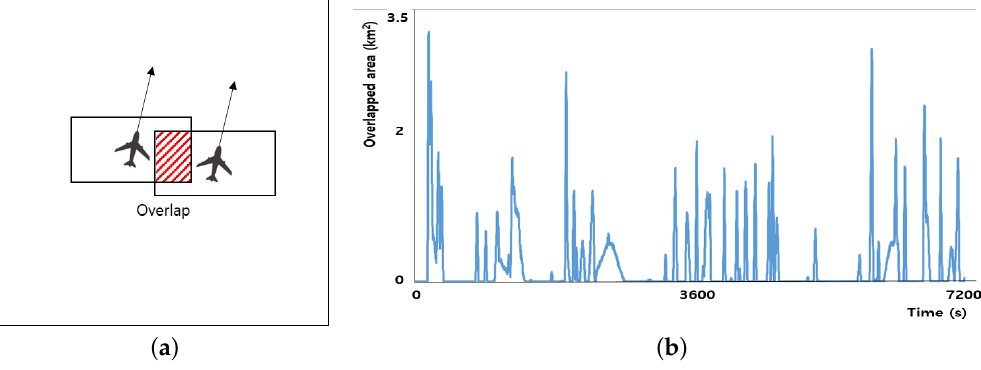
Figure 1. Overlapped reconnaissance and area: ( a ) An example of overlapped reconnaissance; and ( b ) overlapped area simulated for 7200